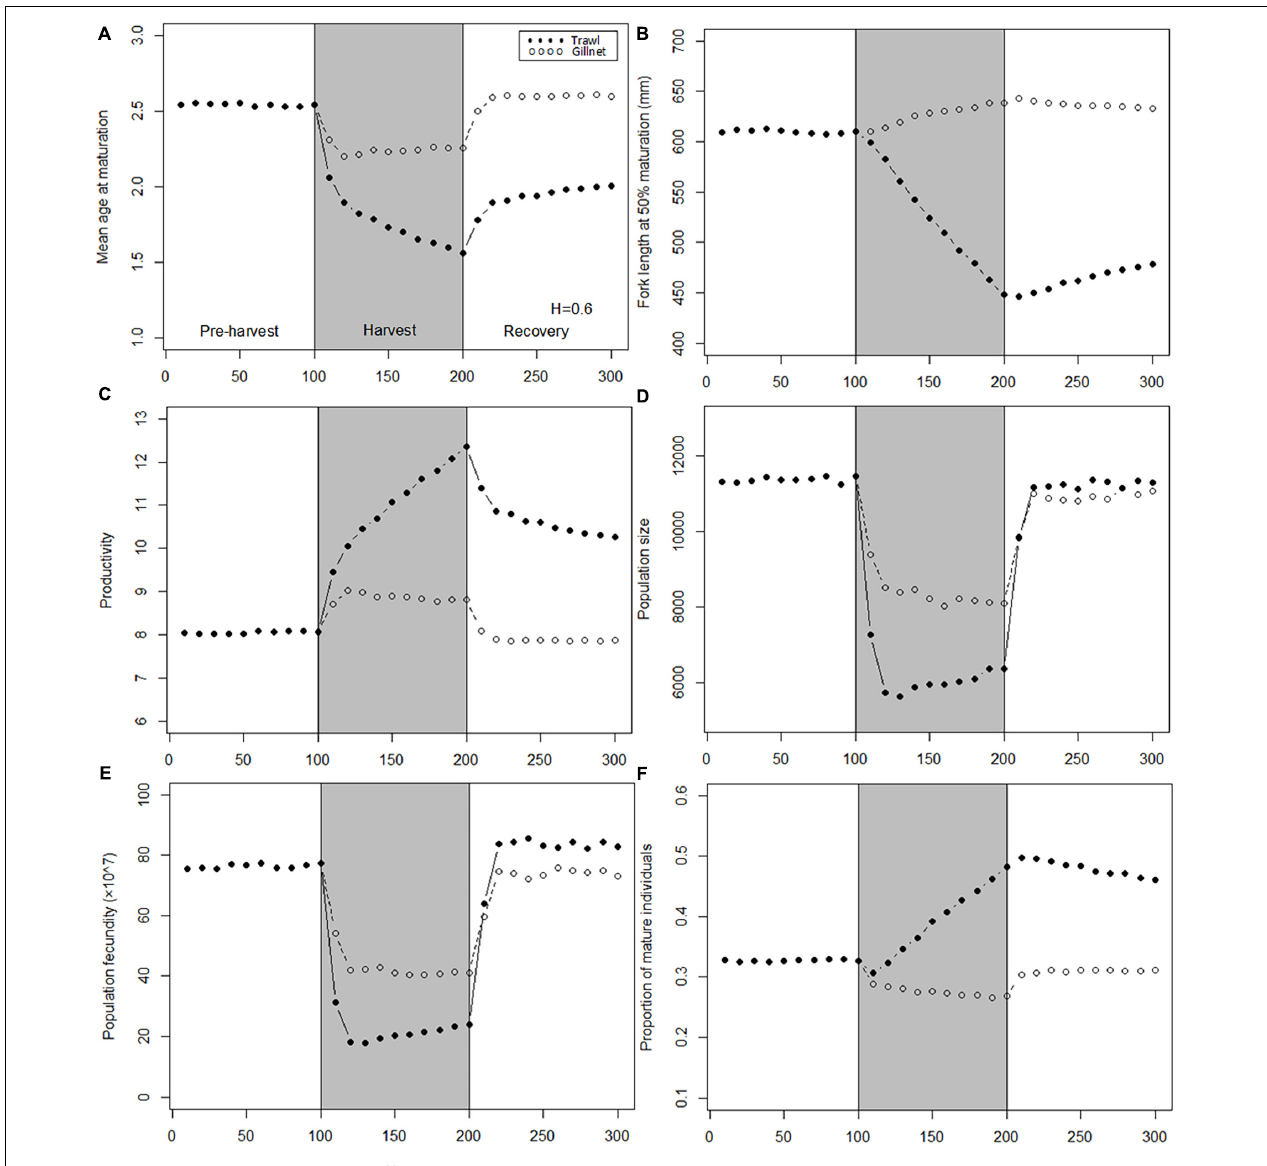
FIGURE 5 | Dynamics of the mean values of population traits before, during and after harvest. Harvest (gray shading) starts at t = 100 years and stop at t = 200 years. Dynamics are shown for two harvest patterns: H = 0.6 year - 1 for trawl (solid points) and H = 0.6 year - 1 for gillnet (hollow points). (A) Mean age at maturation; (B) Fork length at 50% maturation; (C) Population growth rate; (D) Population size; (E) Population fecundity; (F) Proportion of mature